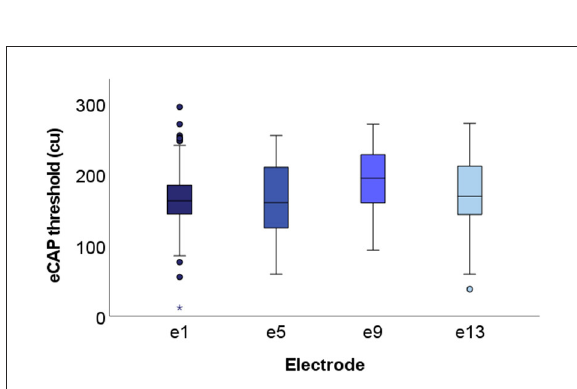
FIGURE6 Boxplots displaying group level eCAP data at each of the four recording electrodes. All successful thresholds from the entire cohort ( N = 15) are included. Specifically, 159, 116, 117, and 122 thresholds (out of a maximum of 180) are included from e1, e5, e9, and e13, respectively. Median values fell within the range of 150–200 cu across all four